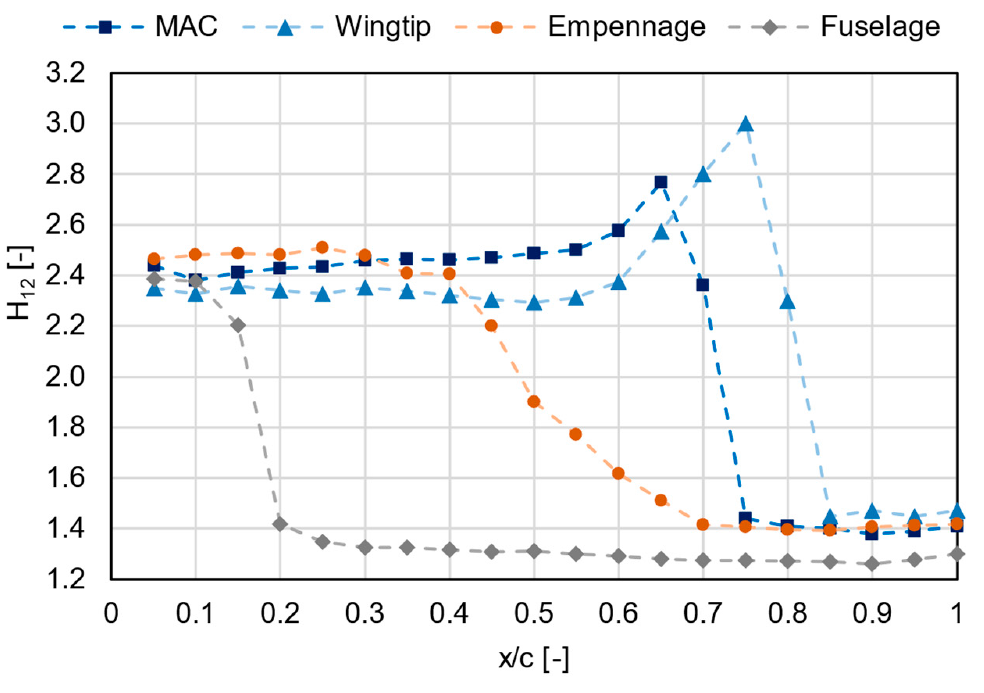
Figure 9. Shape factor distribution on selected planes.